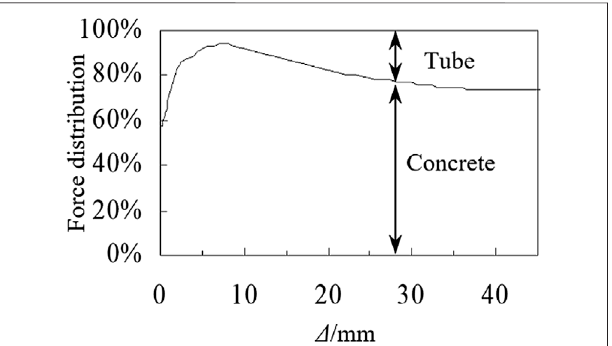
FIGURE 6 | Axial force